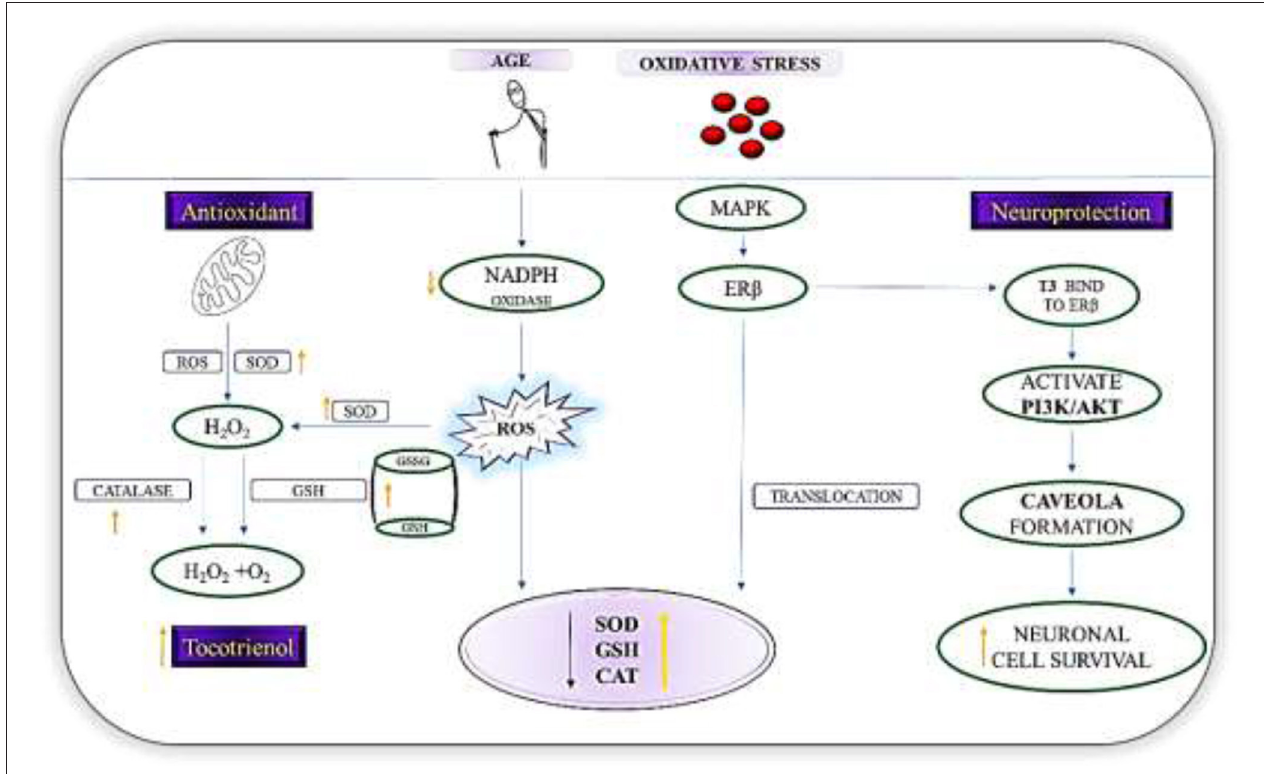
FIGURE 3 | Mechanisms of action of T3s in PD. Diagram shows the role of T3 as a first line defense antioxidants in PD by increasing the level of SOD, GSH, and catalase via the nuclear translocation of ER β and breakdown of H 2 O 2 to harmless molecules (H 2 O 2 /alcohol and O 2 ). T3, via the regulation of NADPH oxidase reduces reactive oxygen species formation. In addition, T3s binds directly ER β , which then triggers the signal transduction pathway and activates PI3K/Akt pathway. Resultantly, caveola will be formed. These initial events constitute an estrogen dependent non-genomic pathway that is